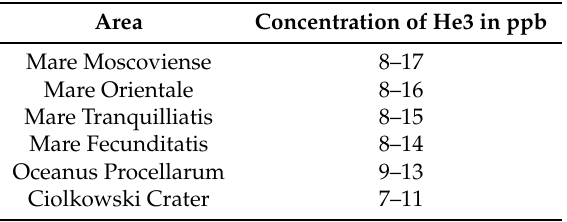
Table 1. Areas of He3 occurrence on the moon [11].